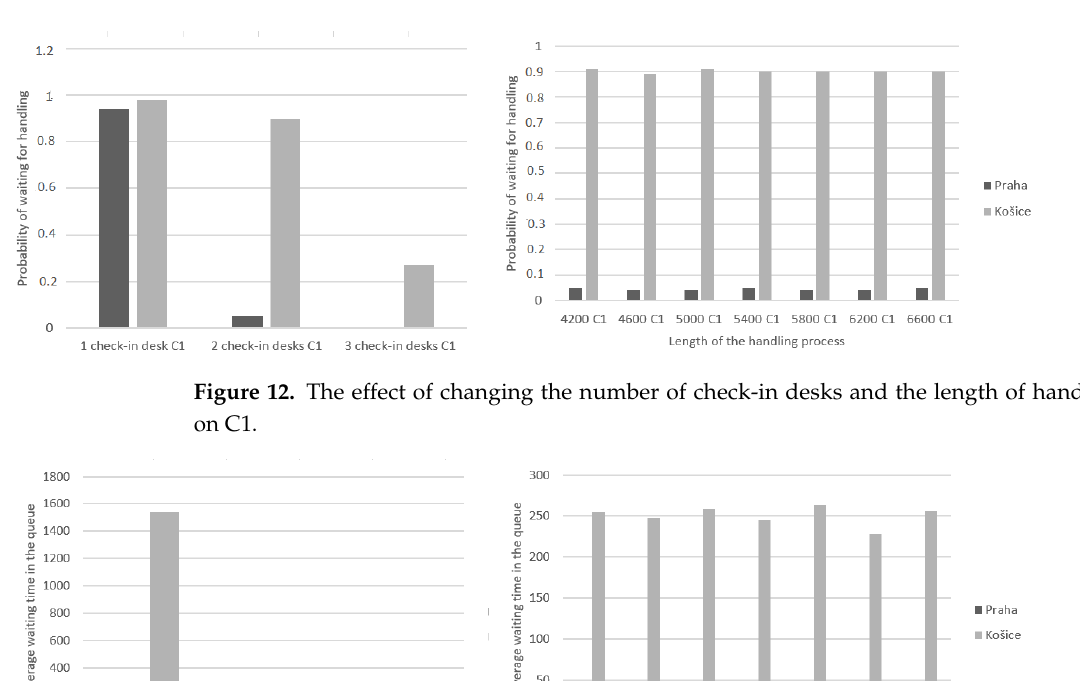
Figure 13. The effect of changing the number of check-in desks and the length of handling time on C4.